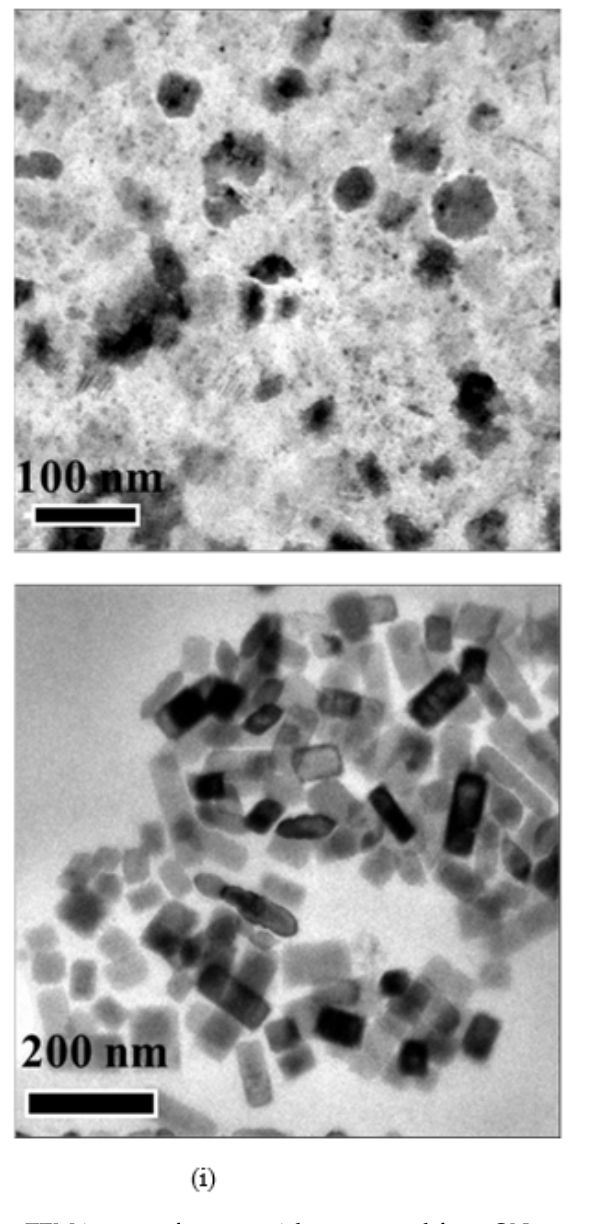
Figure 5. TEM images of nanoparticles generated from ON preparation route during thermal annealing: ( i ) 25 °C and ( ii ) 500 °C where ( a ) CeO x (scale bar = 100 nm) and ( b ) Eu: CeO x (scale bar = 200 nm).